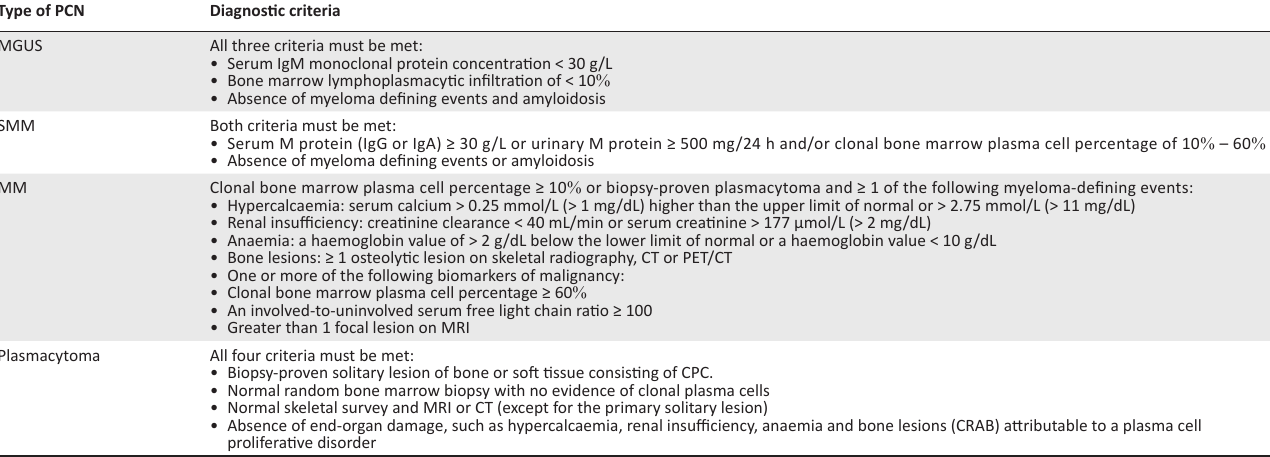
TABLE 1: Diagnostic criteria for plasma cell neoplasms according to the international myeloma working group. Type of PCN Diagnostic